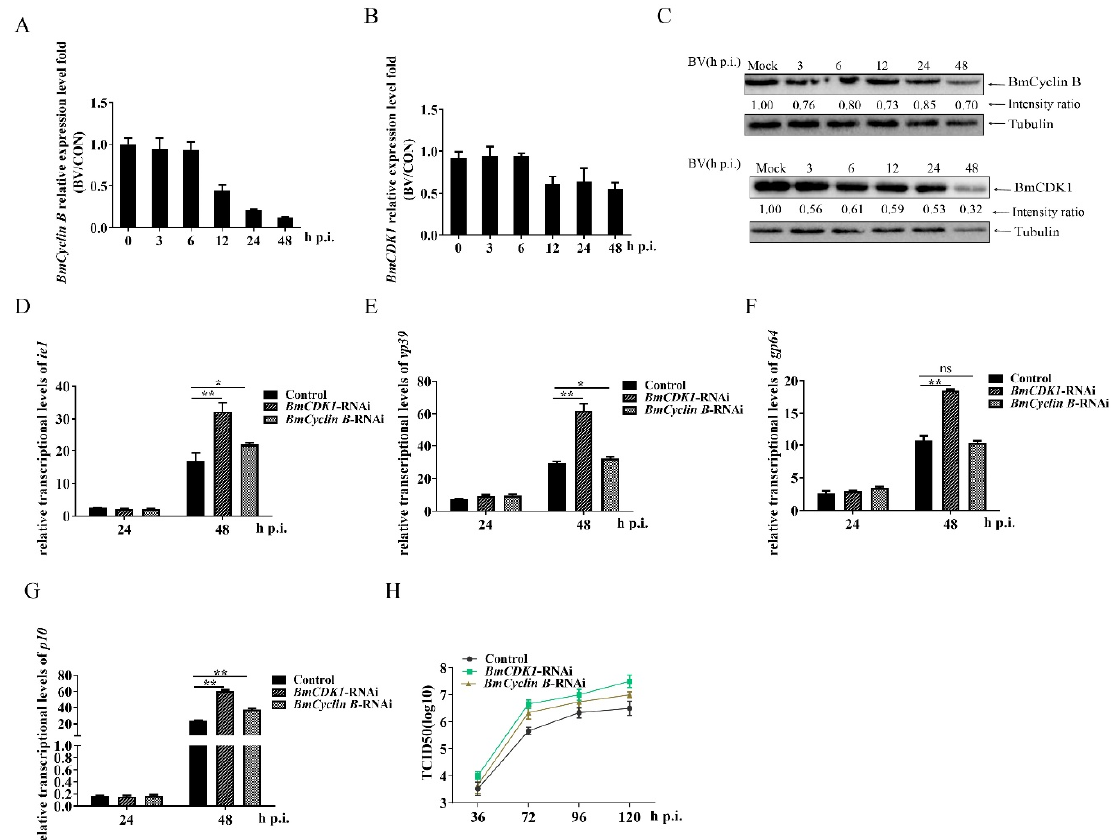
Figure 3. G2/M arrest by BmCDK1 and BmCyclin B enhances BmNPV proliferation. BmN-SWU1 cells were infected with 1 MOI of BmNPV. ( A , B ) The relative expression levels of BmCyclin B and BmCDK1 in different periods of BmNPV infection (BV/CON represented as the ratios of the mRNA levels of BmCyclin B or BmCDK1 in infected cells to that in uninfected cells). ( C ) Western blotting was used to analyze the amount of BmCyclin B and BmCDK1. The protein band density ratios of BmCyclin B and BmCDK1 were calculated by protein band density analysis using Image Lab. Tubulin was adopted as the loading control. ( D , E ) Expression levels of ie1 and vp39 after RNAi silencing of BmCyclin B and BmCDK1 . Cells transfected with pIZ- eGFP were adopted as the control. ( F , G ) Expression levels of gp64 and p10 after RNAi silencing of BmCyclin B or BmCDK1 . ( H ) Viral titer analysis of progeny viruses after RNAi silencing of BmCyclin B or BmCDK1 by TCID50. The data are presented as the mean ± SD of three independent experiments. Statistical differences were analyzed with Student’s t -test ( ns p ≥ 0.05, * p < 0.05, and ** p < 0.01).